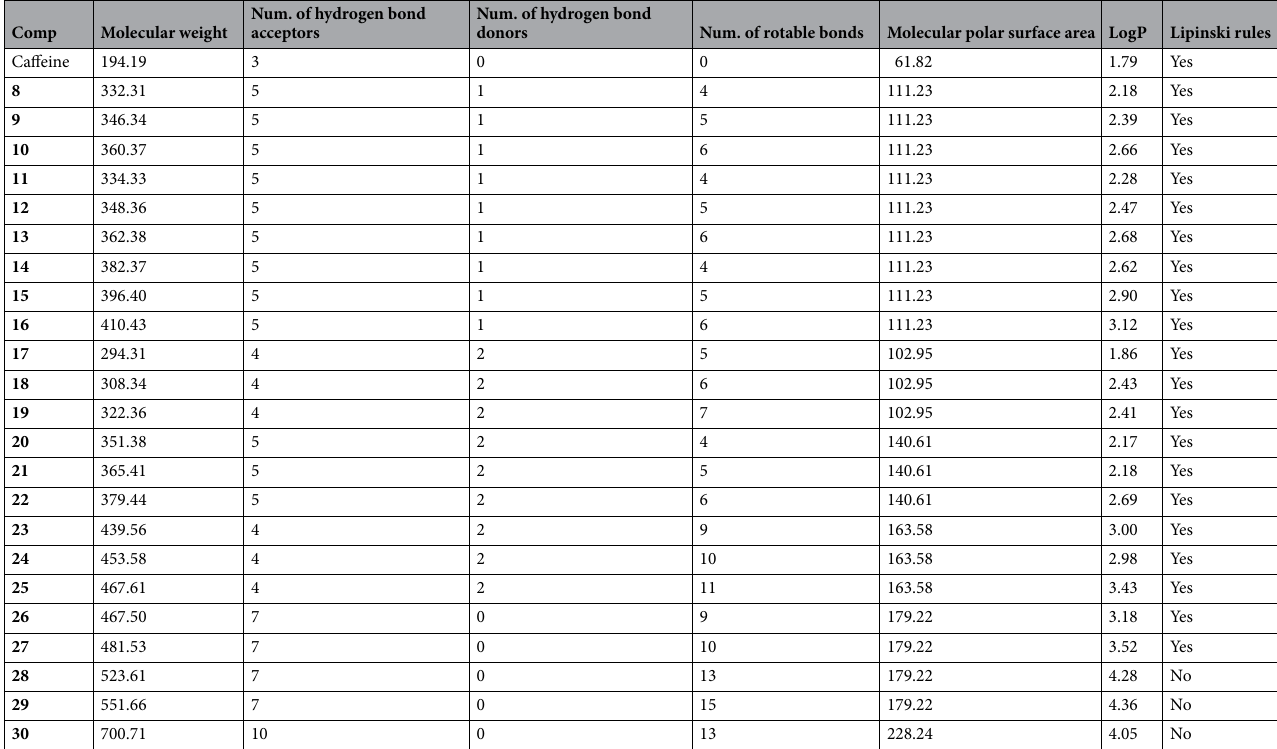
Table 1. Physicochemical properties of 8-substituted aminocaffeine 8–30